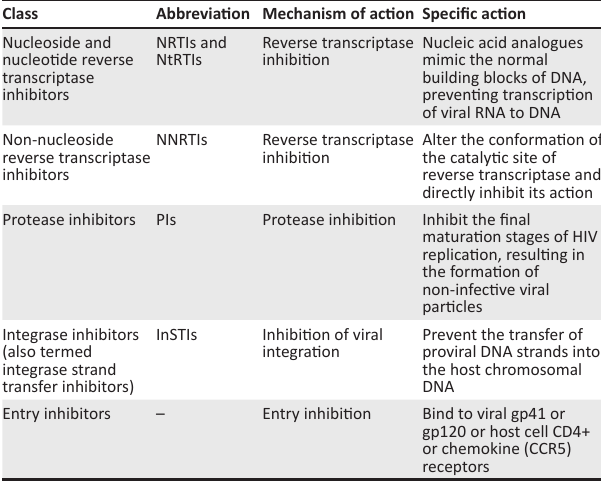
TABLE 1: Classes of antiretroviral agents. Class Abbreviation Mechanism of action Specific action Nucleoside and nucleotide reverse transcriptase